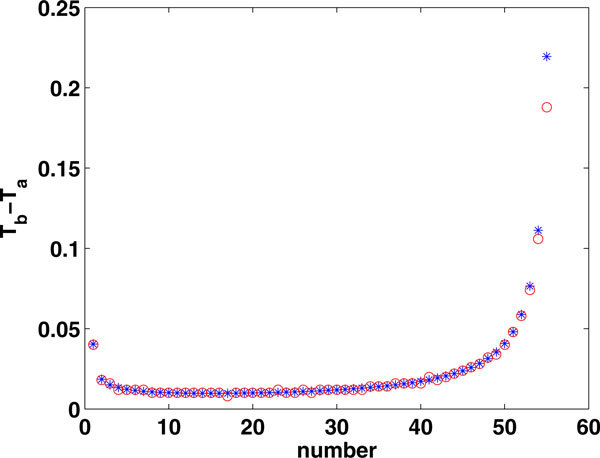
Times between spikes fired by the LIF model with A = 100, p = 10, β = 5, E = 1.2, I = 0.7. The blue symbols show the results of direct simulations of the LIF model with continuous input γ(t) while the red circles show solutions of equations (34), (36) obtained using the serial procedure described in the text.